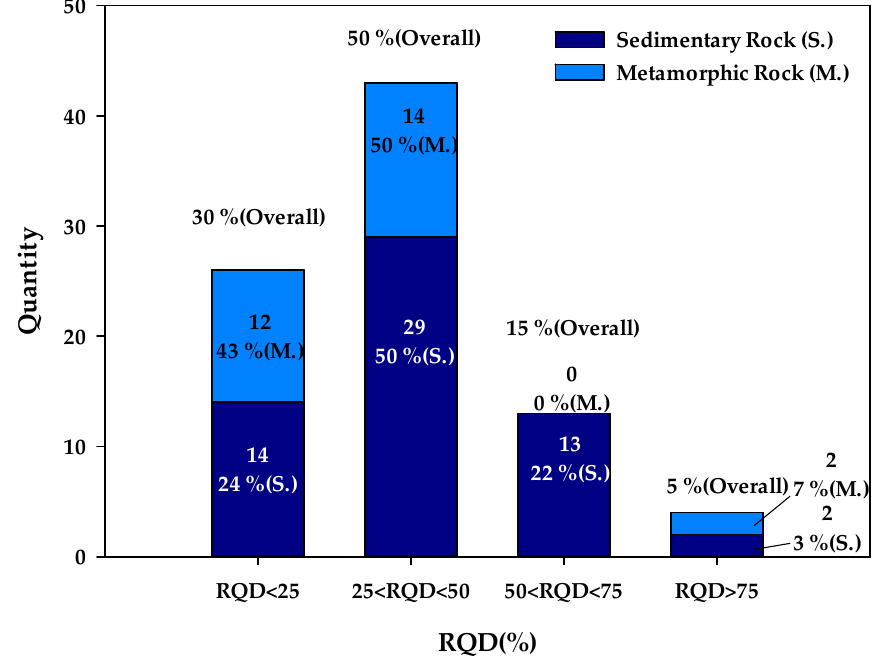
Figure 4. Quantity distribution of different RQD levels for the samples of n >